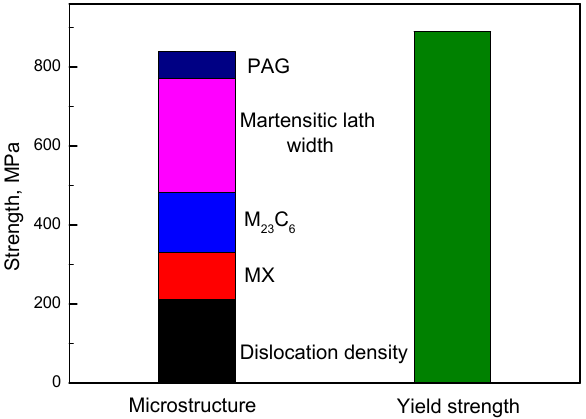
Figure 14. Microstructure contribution strength and yield strength of 15Cr12MoVWN steel.